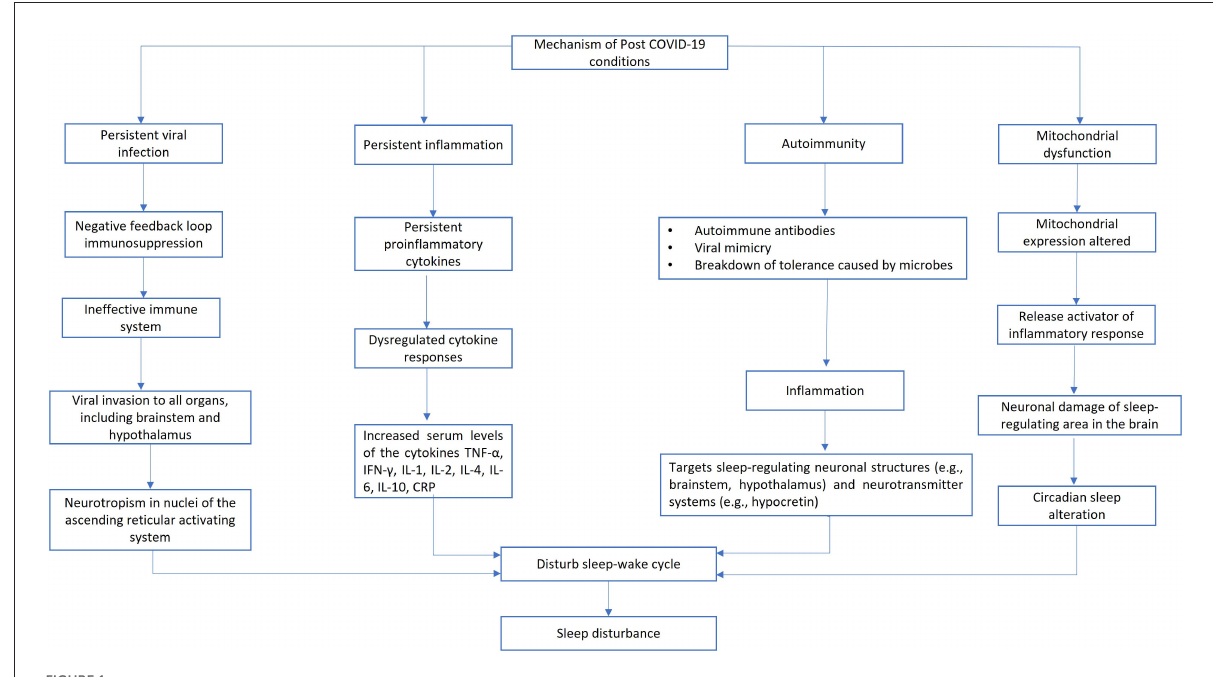
FIGURE1 Possible pathogenic mechanisms of sleep disturbance in post COVID-19